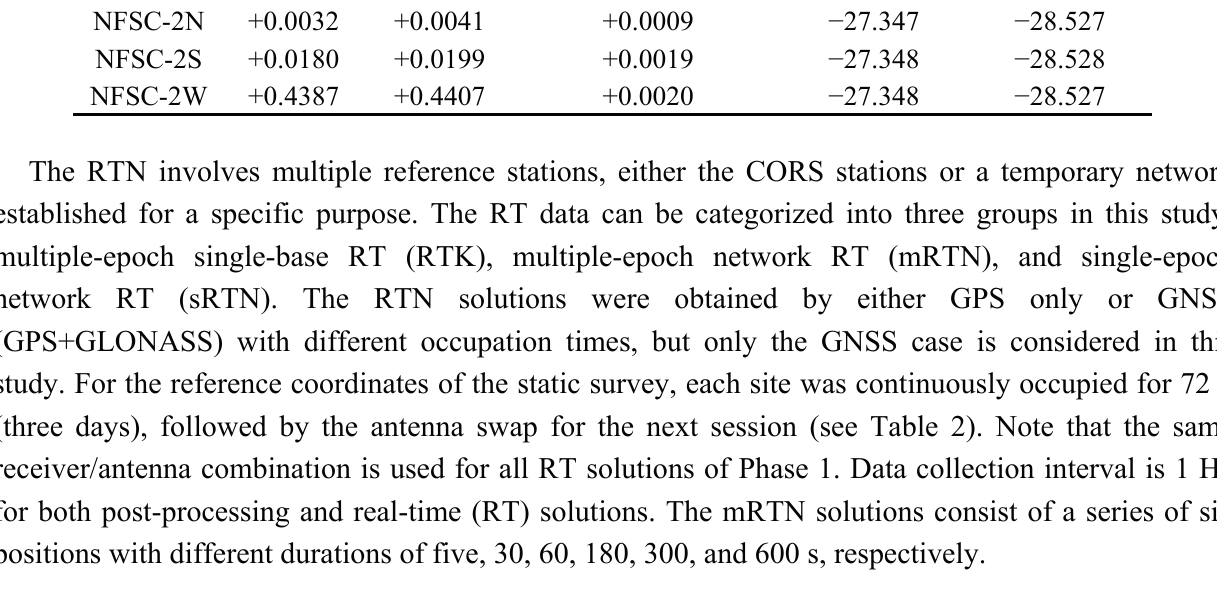
Table 2. Receiver and antenna information for static